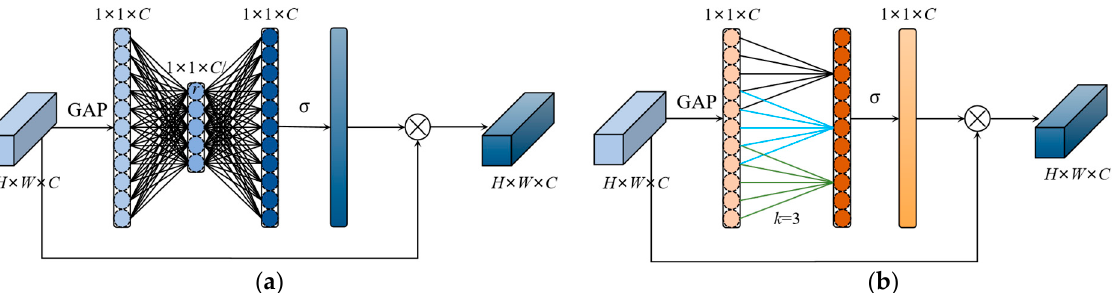
Figure 6. Diagram of SENet and ECANet. ( a ) Diagram of SENet; ( b ) diagram of ECANet. k denotes the convolution kernel size of 1D convolution in ECANet, and k is determined adaptively by mapping the channel dimension C . σ denotes the sigmoid function.